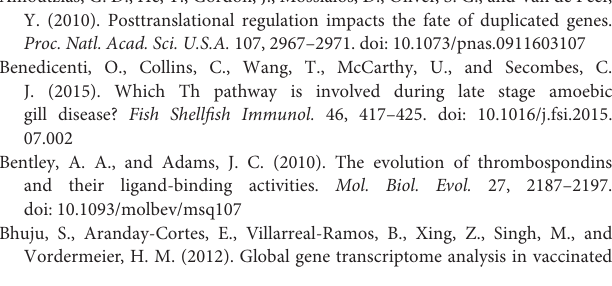
Supplementary Figure 2 | A Venn diagram, showing the overlaps of the differentially expressed transcripts between the samples collected at the naïve (n),